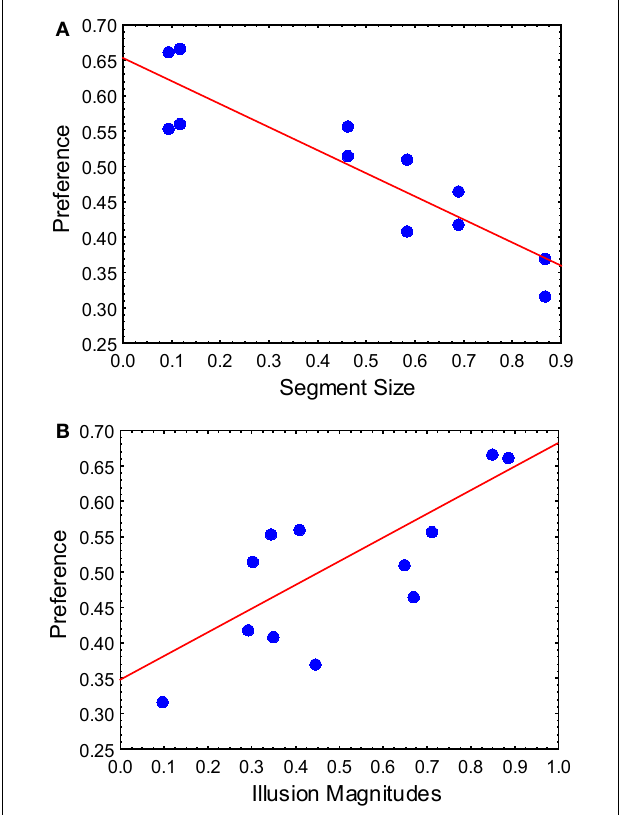
FIGURE 11 | Scatterplots of the regression analysis: a criterion variable was the Preference and predictors were (A) the Segment size and (B) the Illusion